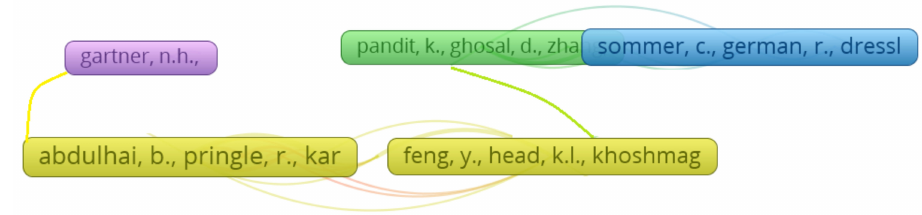
Figure 5. Reference visualization for the 23 connected references resulting from the database of list “A”: the resulting network is still poorly connected.